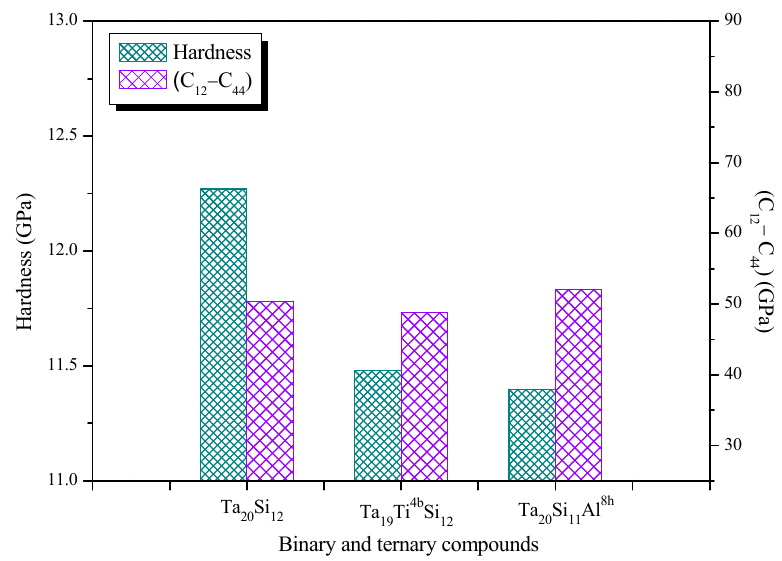
Figure 5. The Vickers hardness and Cauchy’s pressure ( C 12 − C 44 ) for Ta 20 Si 12 , Ta 19 Ti 4b Si 12 and Ta 20 Si 11 Al 8h .